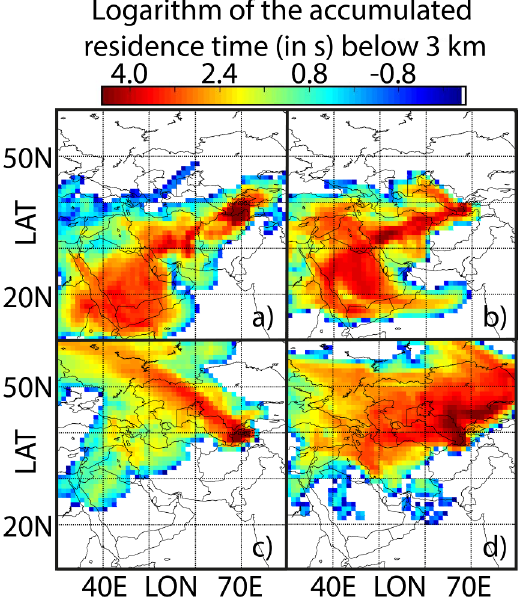
Figure 2: Accumulated residence times of 7-day FLEXPART backward trajectories arriving at Dushanbe at the following dates (UTC) and heights (AGL): a) 13 April 2015, 15:10-16:10, 2.8-3.8 km. b) 23 April 2015, 20:47-21:47, 3-5 km. c) 10 June 2015, 19:00-20:00, 1.4-2.5 km. d) 14 July 2016, 18:30-19:30, 1.4-1-8